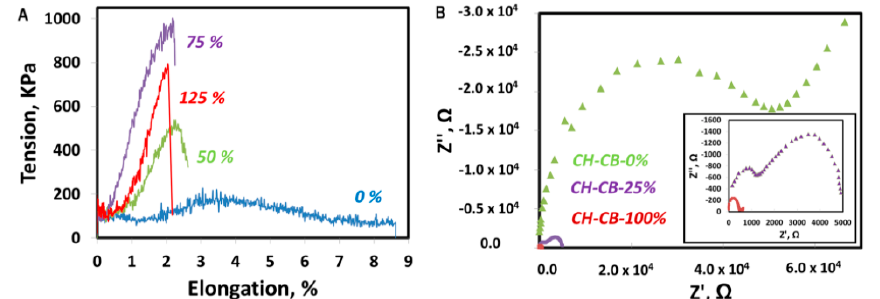
Figure 3. CH-CB membrane mechanical and charge resistance characterization. ( A ) Stress-strain curves of 0 (blue), 50% (green), 75% (purple), and 125% (red) w/w% CB CH-CB membranes. ( B ) Nyquist diagram of a CH membrane 0 (green), 25 (purple), and 100 w/w% CB-CH membrane (red). Inset: magnification of 25 and 100 w/w% CB-CH membranes.